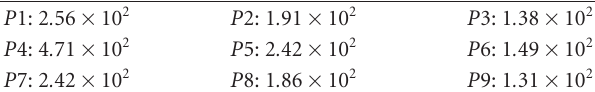
Table 7: The average value of luminance of gray scale D20-B’s nine- spot measurement (Unit: cd/m 2